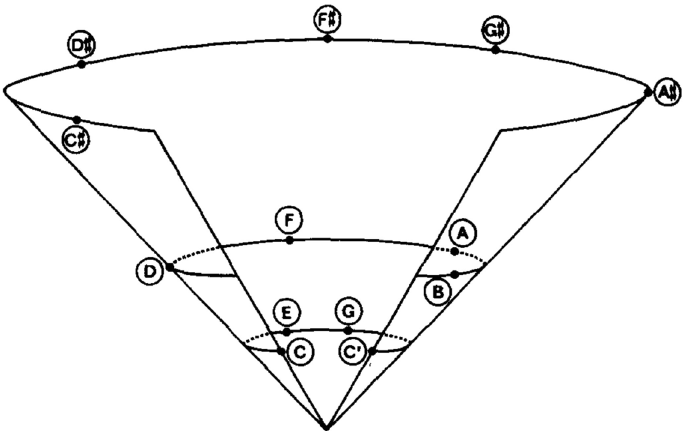
Figure 1. Geometrical representation of perceived similarity between musical pitches within the octave in a tonal context. C major key serves as a reference, such that C represents the tonic (scale degree 1), and C ′ the pitch one octave above C. Taken from Krumhansl 28 , Fig.